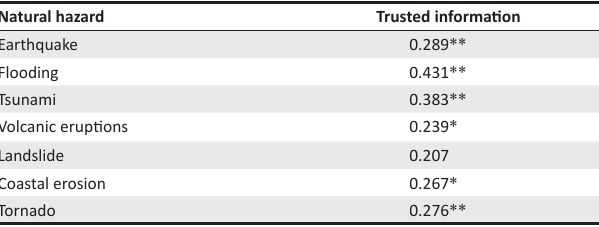
TABLE 5: Summary of correlations between trusted information and influence risk perception.